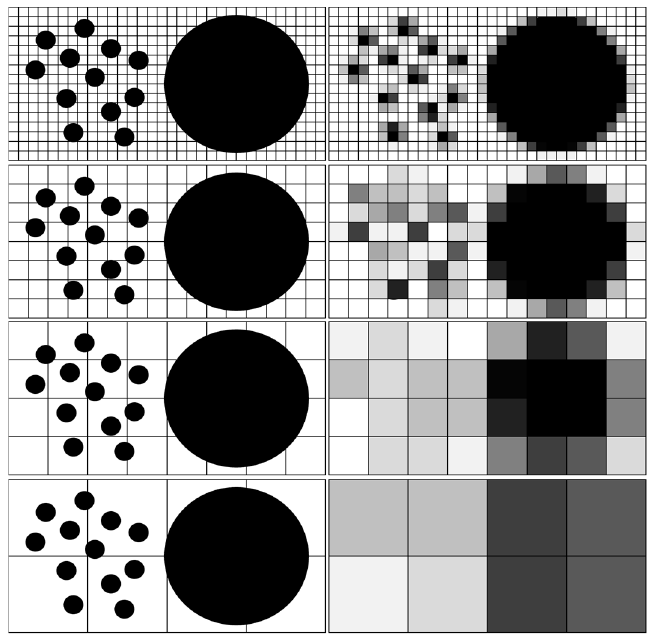
Figure 1. Texture of an image depending on its spatial resolution.